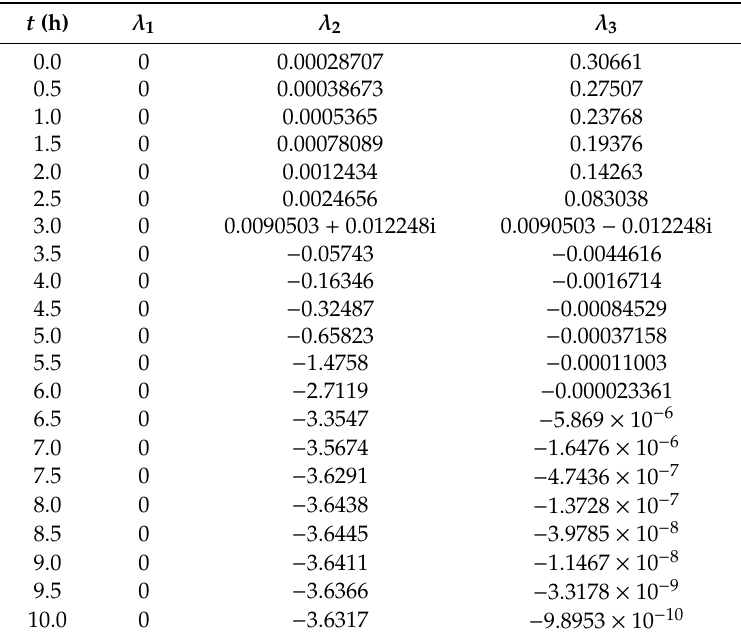
Table 2. Eigenvalues of the linearised mathematical model of a non-linear model of the analysed fermentation process in a batch